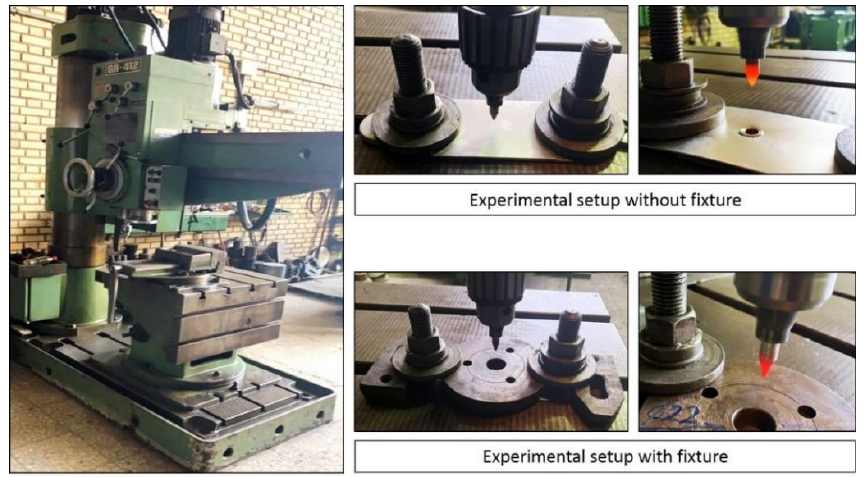
Figure 3. Experimental setup for the friction drill joining process.